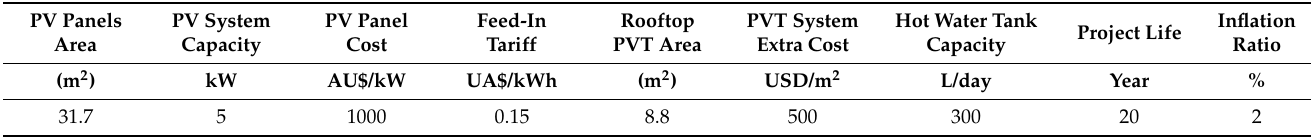
Table 4. PV and PVT financial